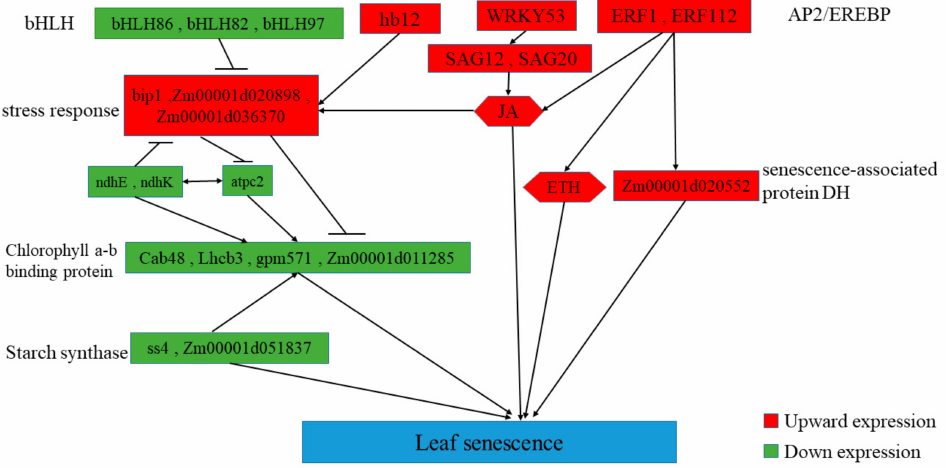
Figure 11. Predicting the regulatory process of premature senescence of mutant